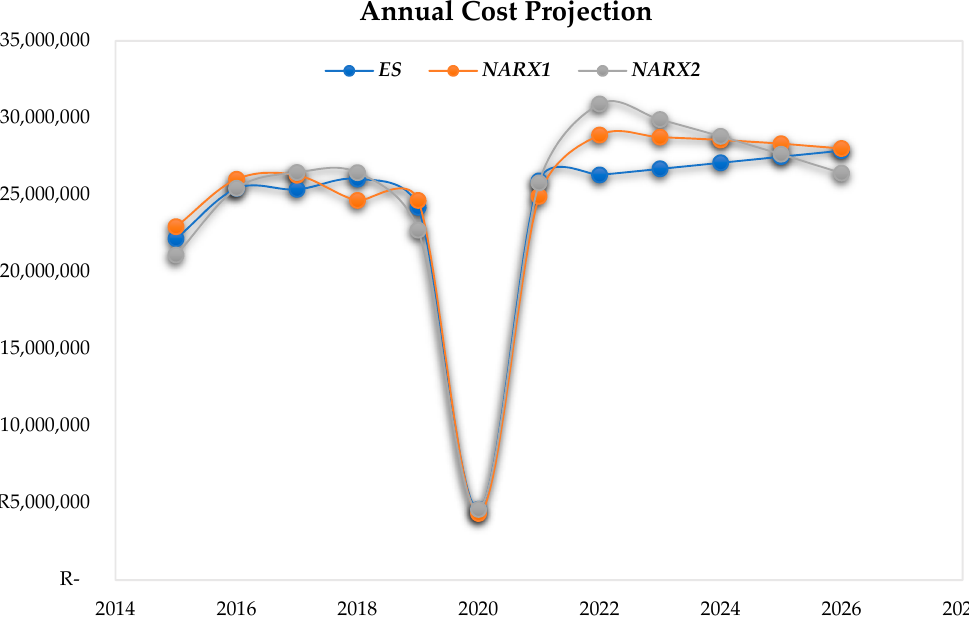
Figure 9. UJ-Res annual energy cost history and projection over the next five years.